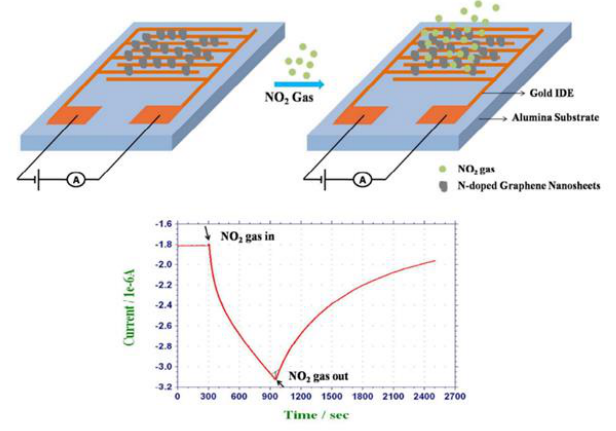
Figure 14. NGS/IDE for detection of NO 2 gas at room temperature. Reprinted with permission from [74].